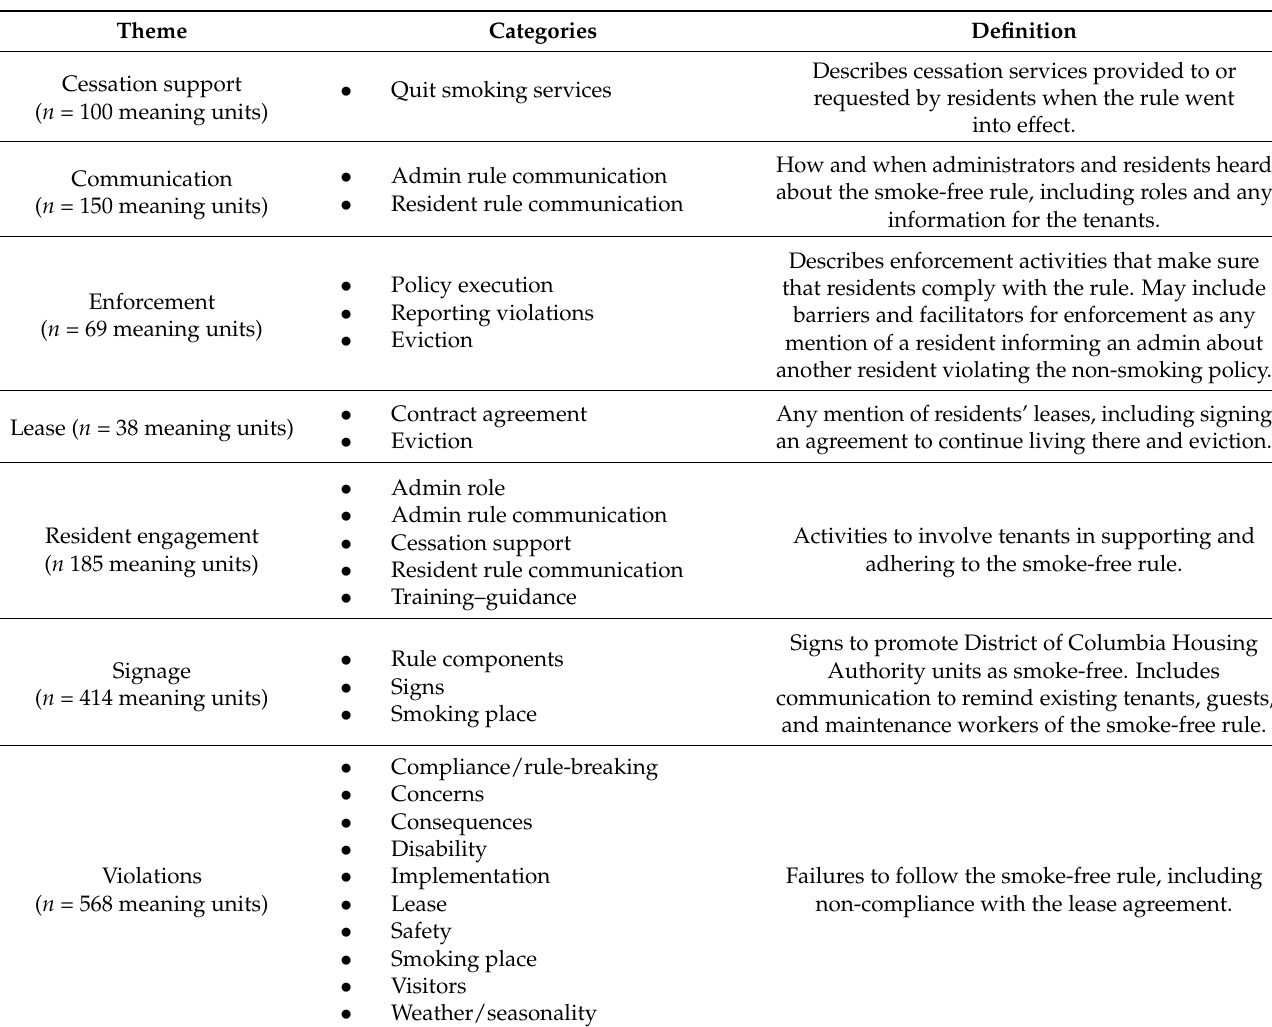
Table 3. Main study themes, meaning units, categories, and code